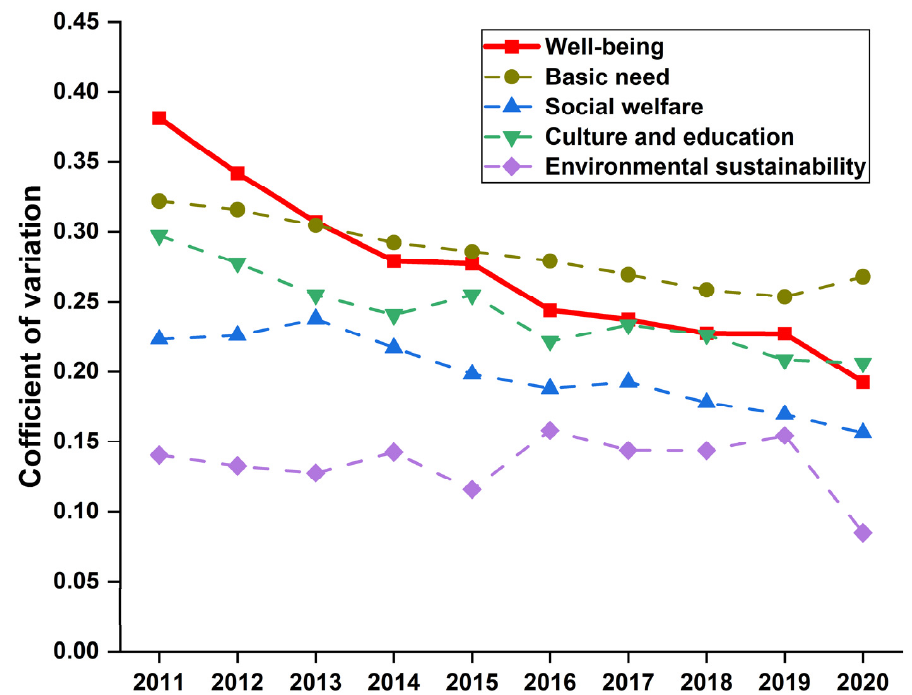
Figure 7. CV values of four subsystems and well-being from 2011 to 2020.